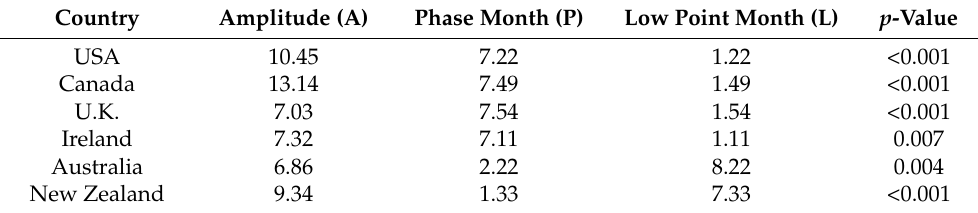
Table 1. Country-wise seasonal variations in search volume data for “plantar fasciitis” using Google Trends.